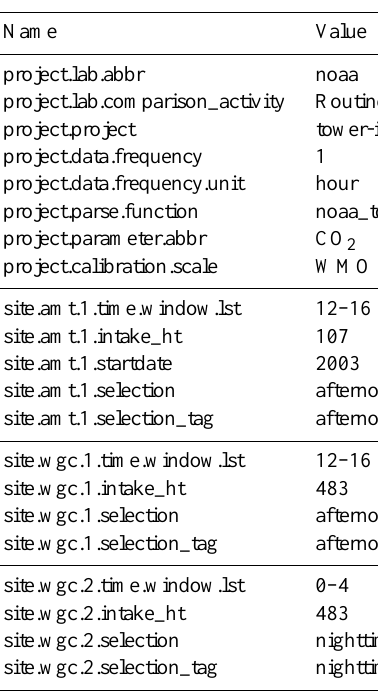
Table 1. Excerpt from an ESRL tower-insitu configuration